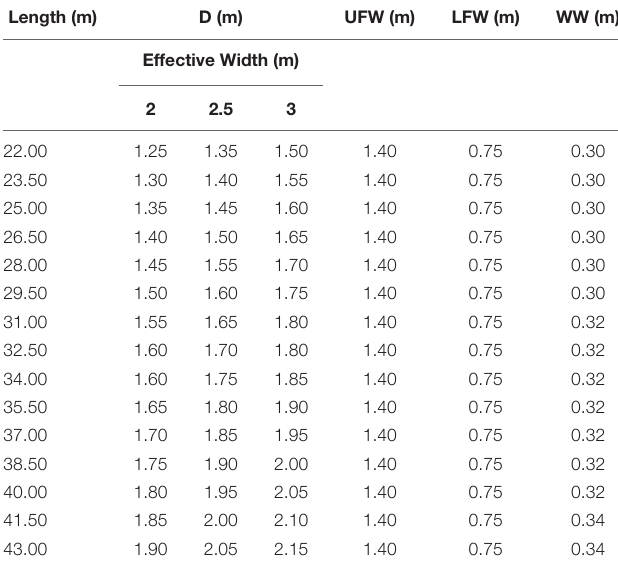
TABLE 6 | Proposed Standardized Extended-I Beams for precast bridges. Length